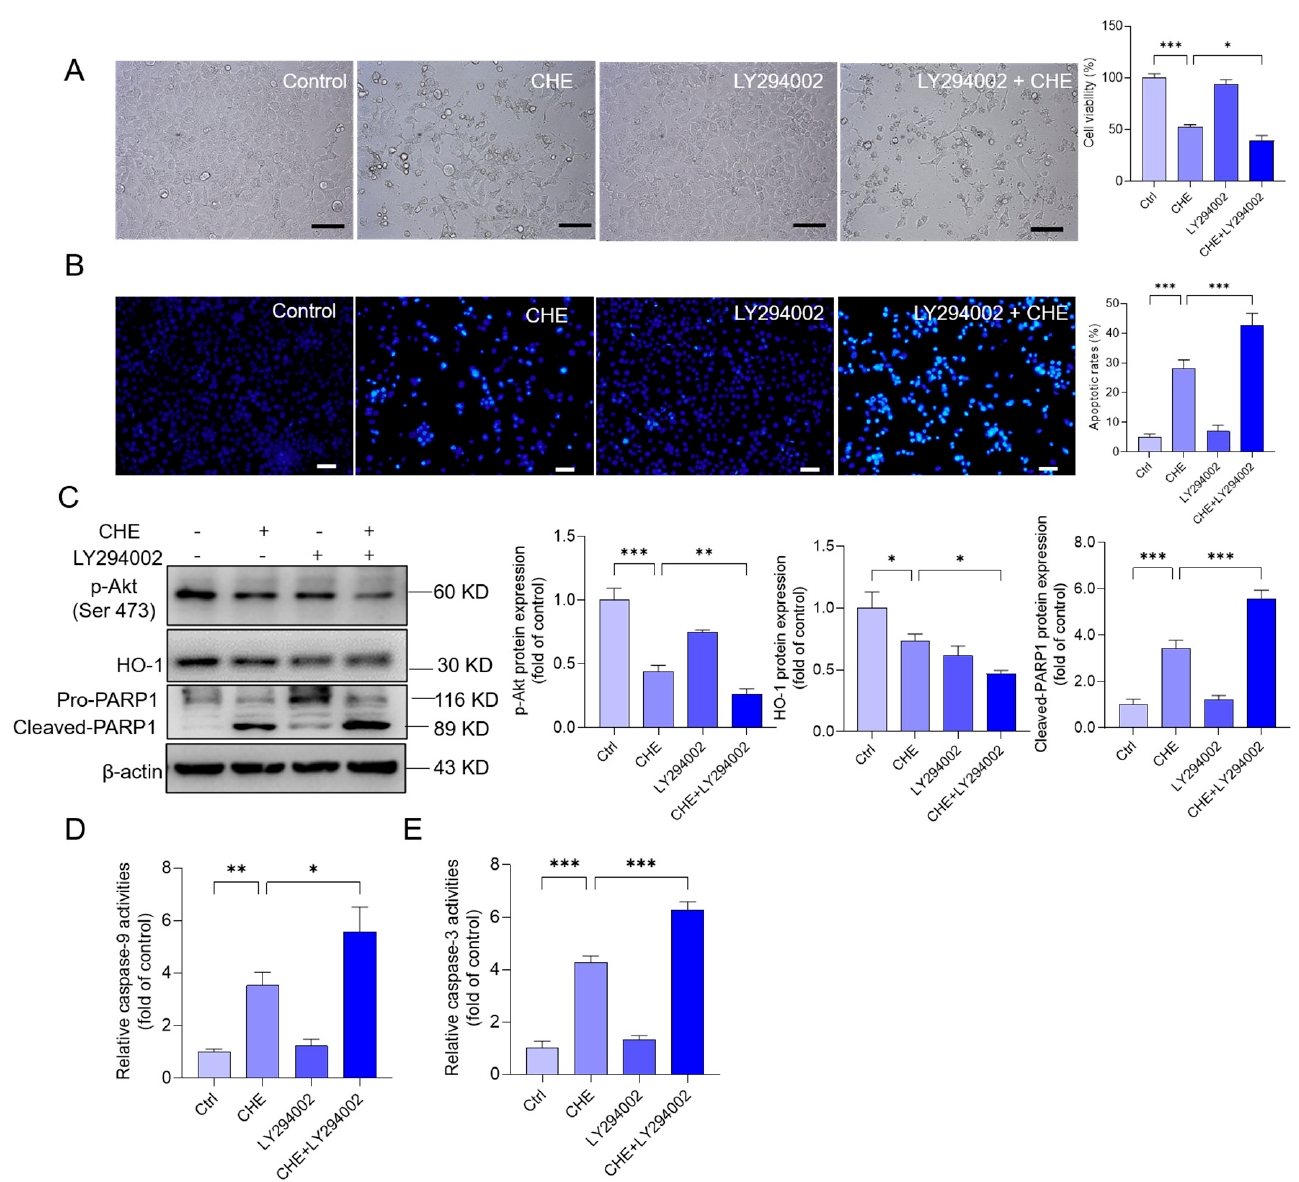
Figure 7. Effects of Akt inhibition on the cell viability, apoptosis, and protein expression in HepG2 cells exposed to CHE. ( A ) HepG2 cells were pretreated with LY294002 (at a final concentration of 10 µ M) for 2 h, followed by treatment with CHE at 10 µ M for an additional 24 h. The morphological changes (on the left) were observed and the changes in cell viability (on the right) were measured. ( B ) measurement of cell apoptosis. The representative images (on the left) and the quantitative analysis (on the right) are shown. ( C ) the expressions of p-Akt, HO-1, and PRAP1 proteins were performed by using the Western blotting method. ( D , E ) The levels of caspase-9 and caspase-3 activities. Data are shown as mean ± S.D. ( n = 3 independent experiments). * p < 0.05, ** p < 0.01 or *** p < 0.001, indicated the significant differences between the two groups. Scale Bar = 50 µ